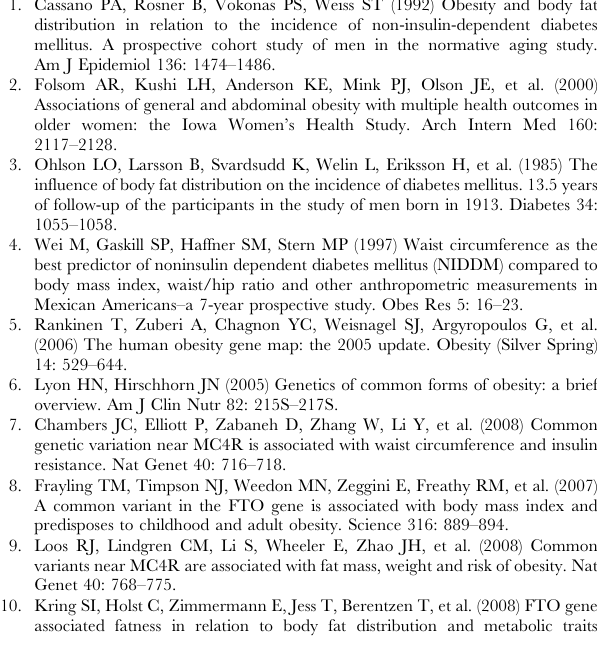
Figure S1 CHARGE consortium Manhattan plot for waist circumference. Figure S2 CHARGE consortium QQ plot for waist circumfer- ence. Found at: doi:10.1371/journal.pgen.1000539.s002 (0.44 MB TIF) Figure S3 Forest plot for rs10146997. Found at: doi:10.1371/journal.pgen.1000539.s003 (0.37 MB Figure S4 CHARGE consortium Manhattan plot for Body Mass Index. Figure S5 CHARGE consortium QQ plot for Body Mass Index. Table S1 Summary of imputation and statistical analysis methods across the cohorts.